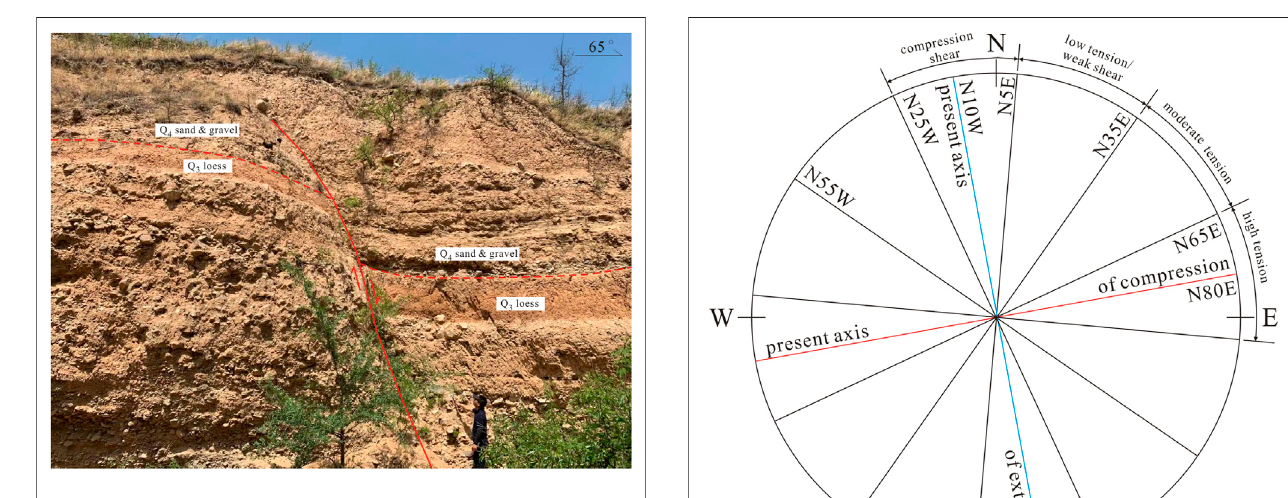
Table 2 . The faults observed are mainly normal faults, and only a few ENE-striking (F 3 ) and WE-striking (F 1 ) faults are reverse faults. The latest active time of the faults found through fi eld investigation is in Quaternary; thus, the main faults in the study area are neotectonic faults ( Figures 2 , 3 ) (Qi and Feng, 2019), except for F 2-5 and F 2-6 , which were developed in Jurassic, and no obvious signs of neotectonic activities were found. In total, 19 neotectonic faults were identi fi ed ( Table 2 ).